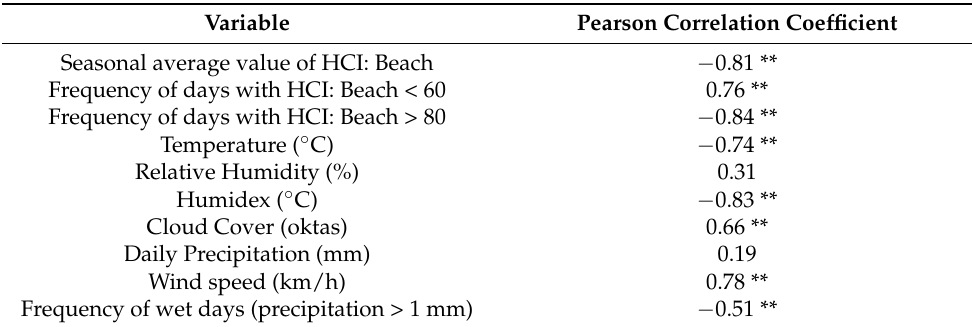
Table 1. Values of the Pearson Correlation Coefficient between latitude and original climate variables and derived variables after the calculation of HCI: Beach. ** stands for values statistically significant at the 99% confidence level.